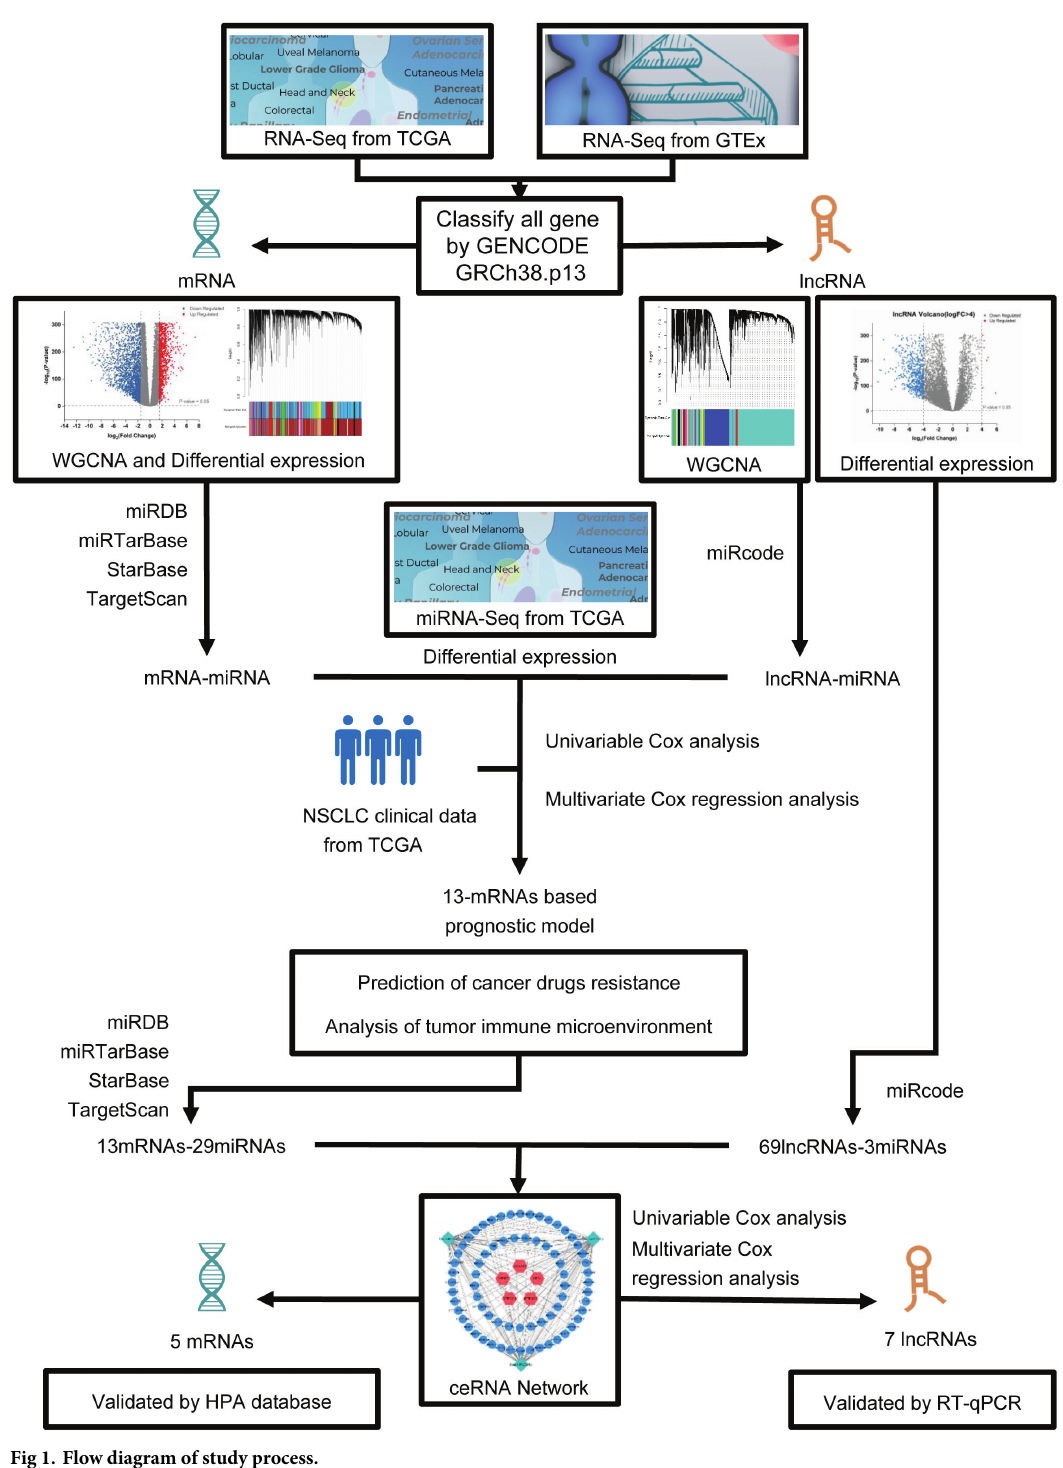
Fig 1. Flow diagram of study process.